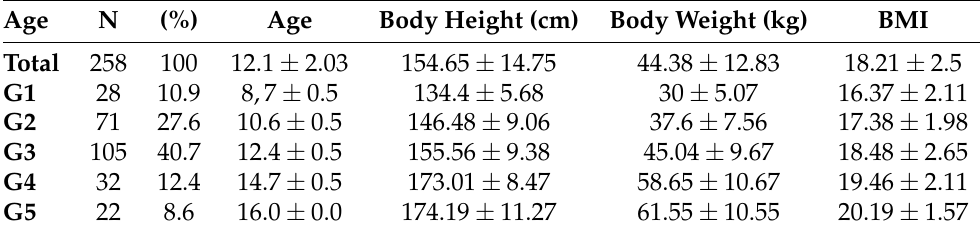
Table 1. Characteristic of